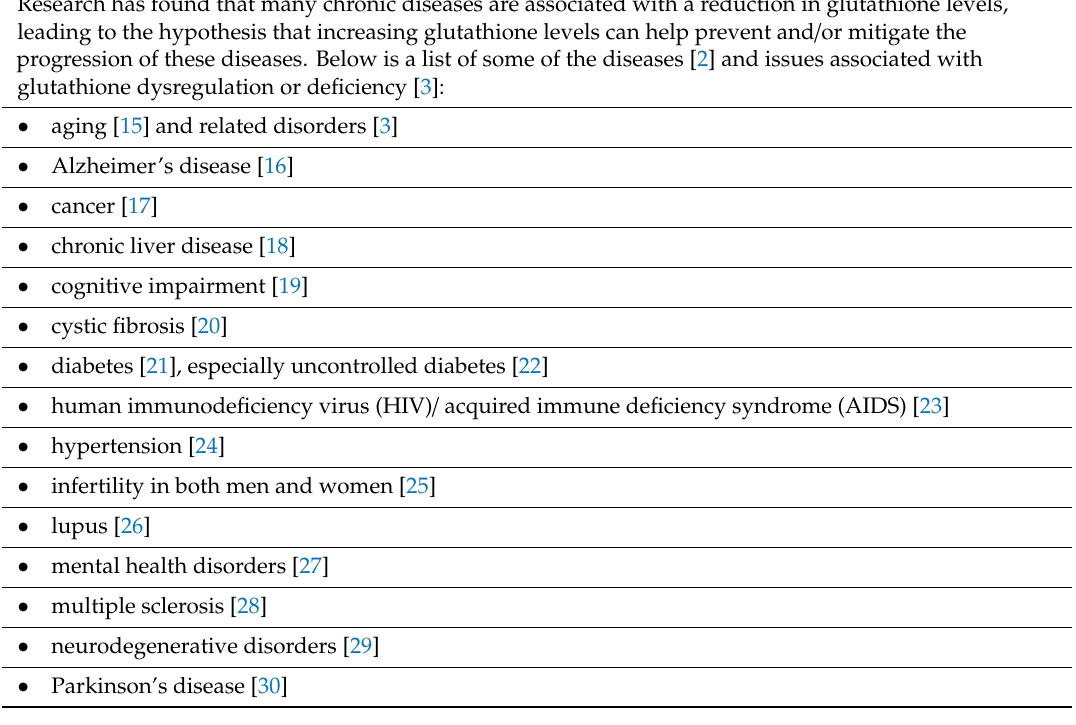
Table 1. Clinical conditions and diseases associated with